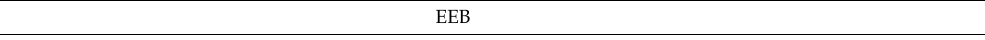
Table 4. Illustrative